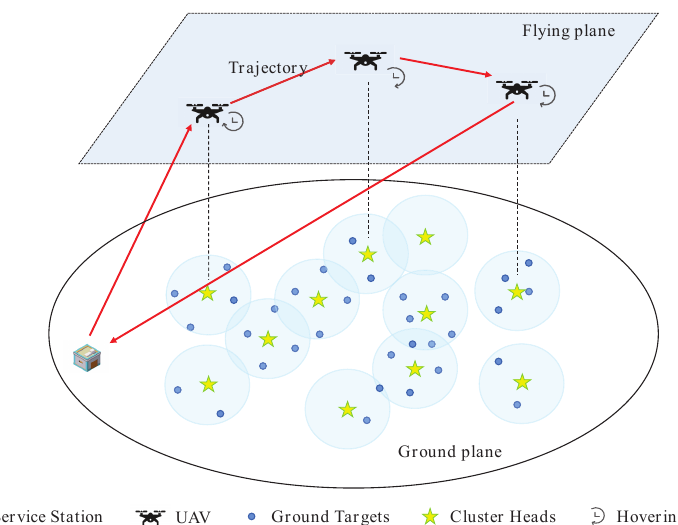
Figure 2. A diagram of the shooting